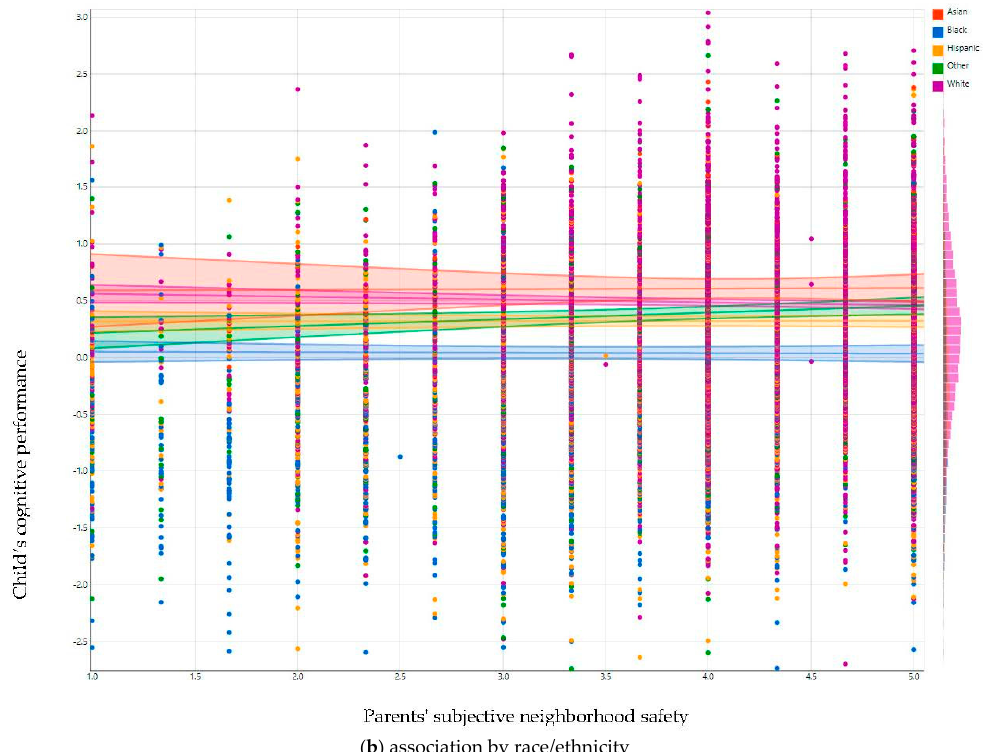
Figure 2. Association between parents’ subjective neighborhood safety and children’s general cognitive function overall and by race/ethnicity.